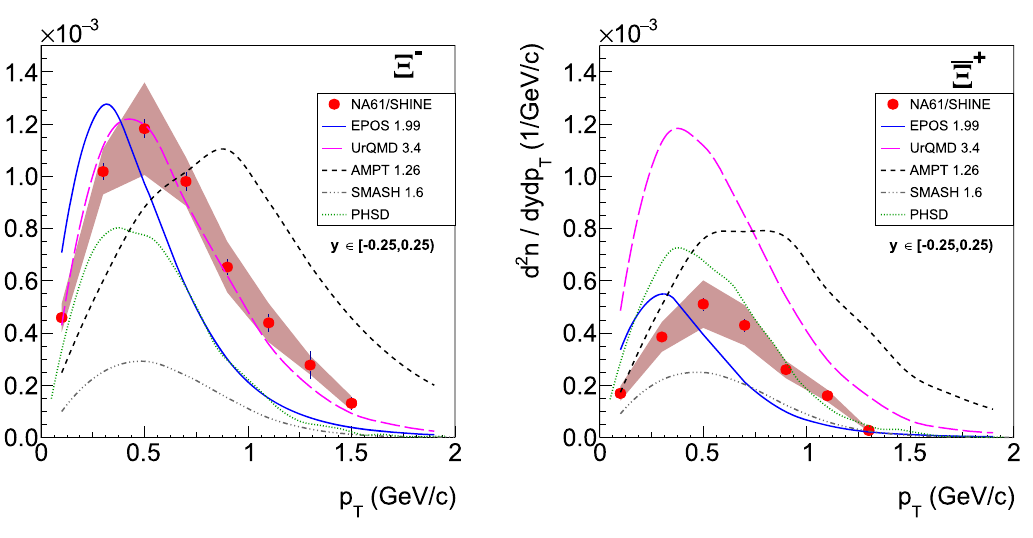
Fig. 8 Transverse momentum spectra at mid-rapidity of (cid:2) − ( left ) and (cid:2) + ( right ) produced in inelastic p+p interactions at 158 GeV / c . Rapid- ity range is included in the legends. Shaded bands show systematic blue, black, gray and green lines,